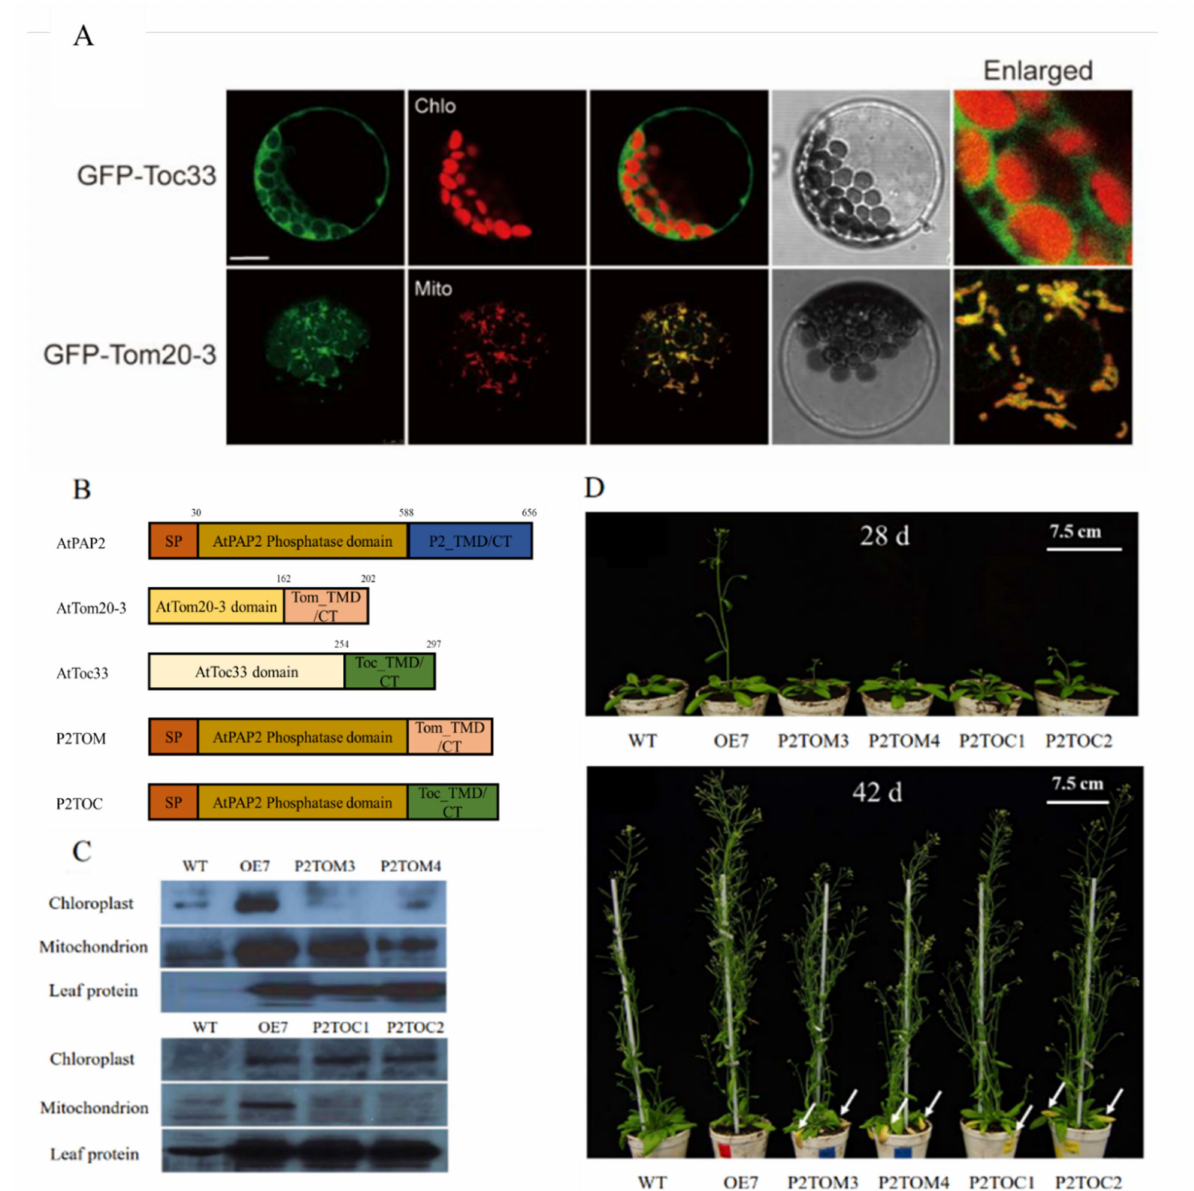
Figure 1. Growth phenotypes of AtPAP2 overexpression lines. ( A ) Transient expression of GFP-Toc33 and GFP-Tom20-3 in Arabidopsis protoplasts. Protoplasts were transformed with constructs of AtToc33 and AtTom20-3 fused with GFP at their N-termini, respectively. Representative confocal images of GFP fluorescence are shown. Chlo, chloroplast auto-fluorescence; Mito, mitochondria marked by Mitotracker. Scale bar, 10 µ m. ( B ) Construction of P2TOC and P2TOM overexpression vectors that replaced C-terminal motif of AtPAP2 with that of AtToc33 or AtTom20-3. ( C ) Confirmation of AtPAP2 expression in chloroplasts and/or mitochondria and total leaf protein of transgenic lines by Western blotting analysis using anti-AtPAP2 antibodies. ( D ) 28- and 42-day-old plants under a long-day (16 h/8 h) regime. The yellow necrotic spots were indicated by white arrows. Scale bar, 7.5